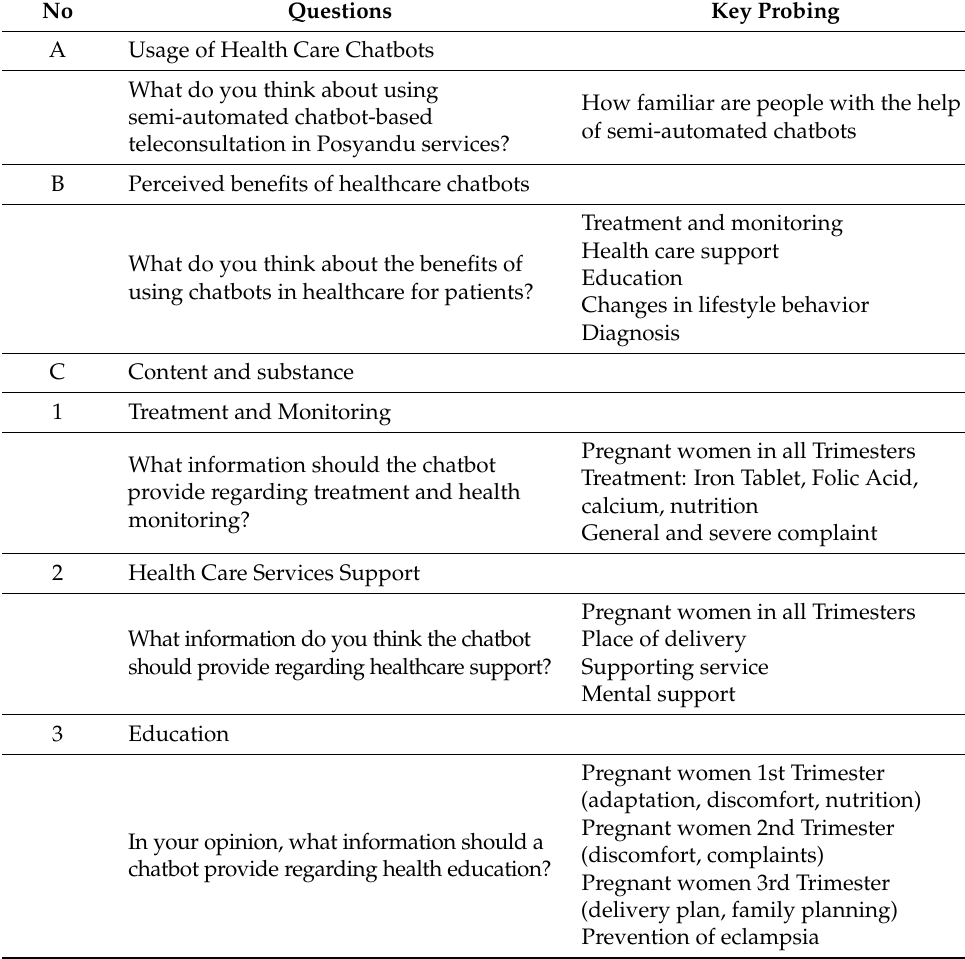
Table A1. Guidelines for Focus Group